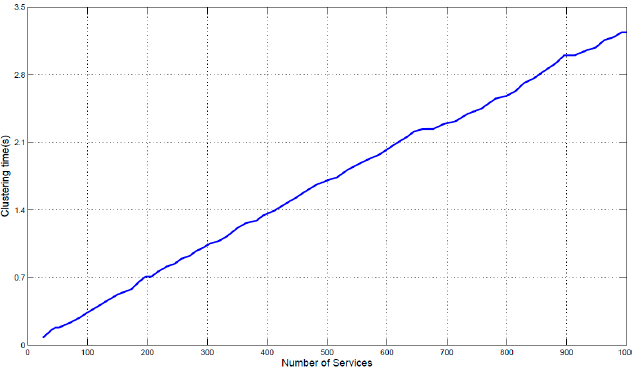
Figure 8. The time of clustering influenced by services number.